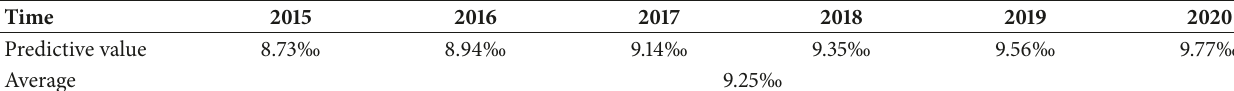
Table 3: Predictive value of birth rate and its average.